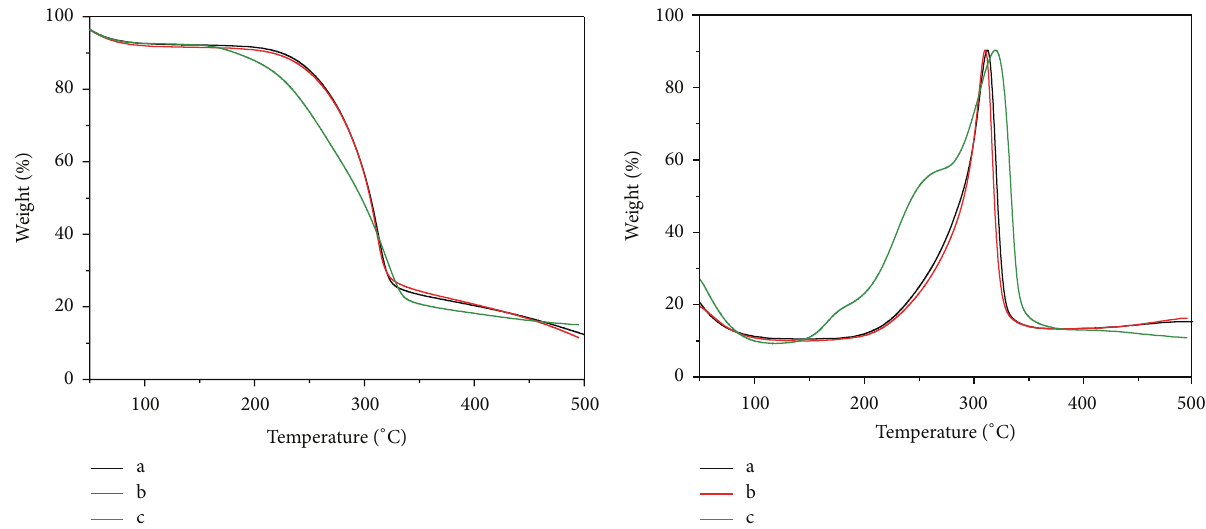
Figure 5: The TG/DTG curves of unmodified cellulose (C0, curve a) and phthalated cellulose samples (C1, curve b; C5, curve